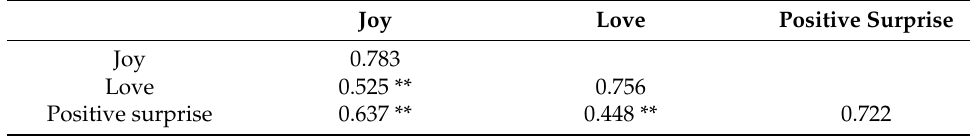
Table 4. Differential validity among positive emotion variables.